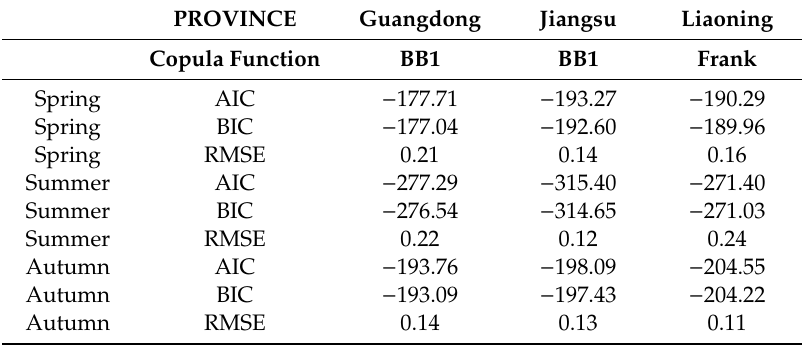
Table 4. Copula function cluster selection criteria for Tmax–NDVI in Guangdong, Jiangsu and